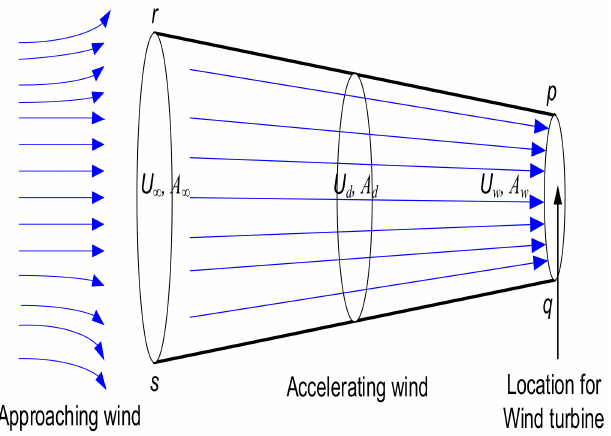
Figure 4. Wind flow through the